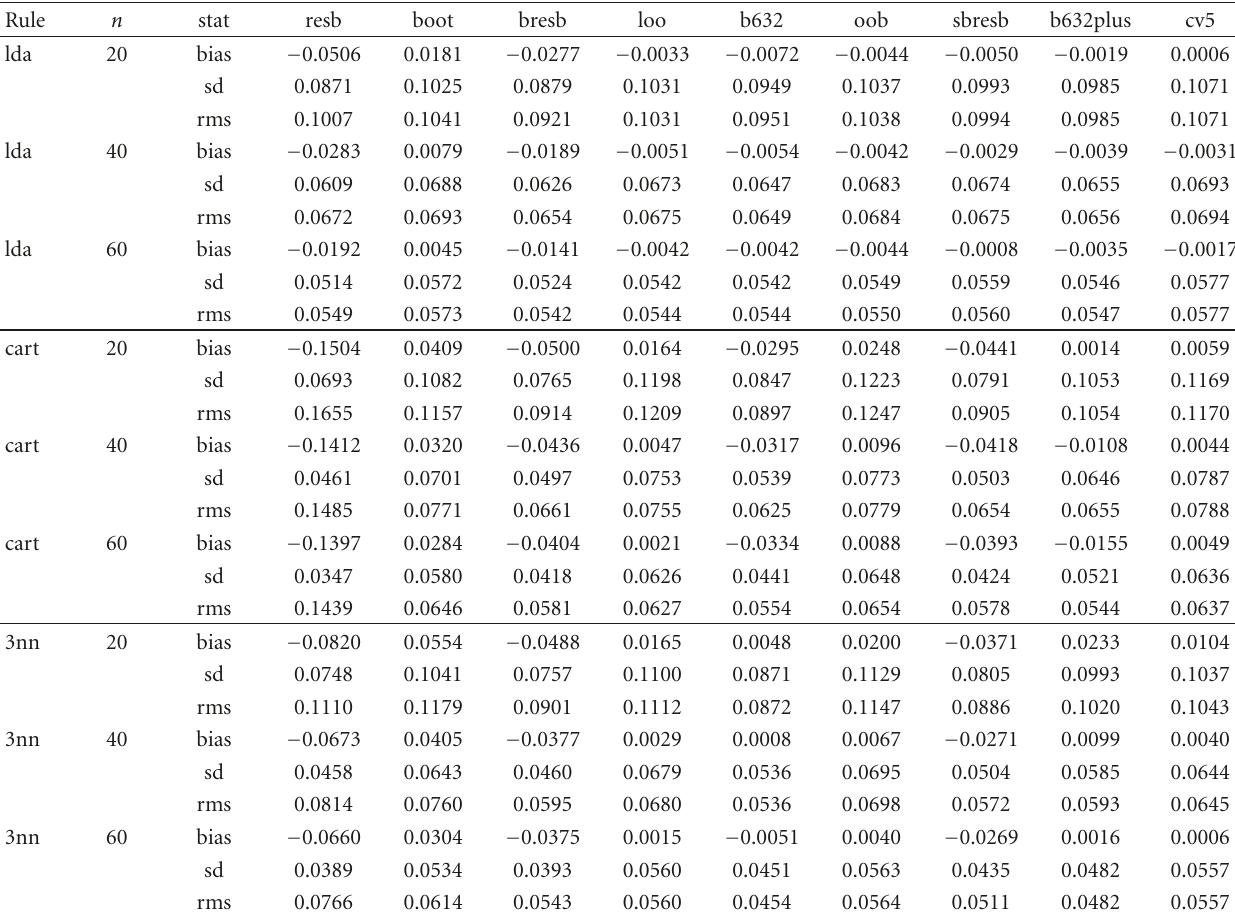
Table 3: Bias, variance (standard deviation), and RMS for di ff erent error estimators, with di ff erent base classification rules, for prostate cancer mass-spectrometry data, and dimensionality p =